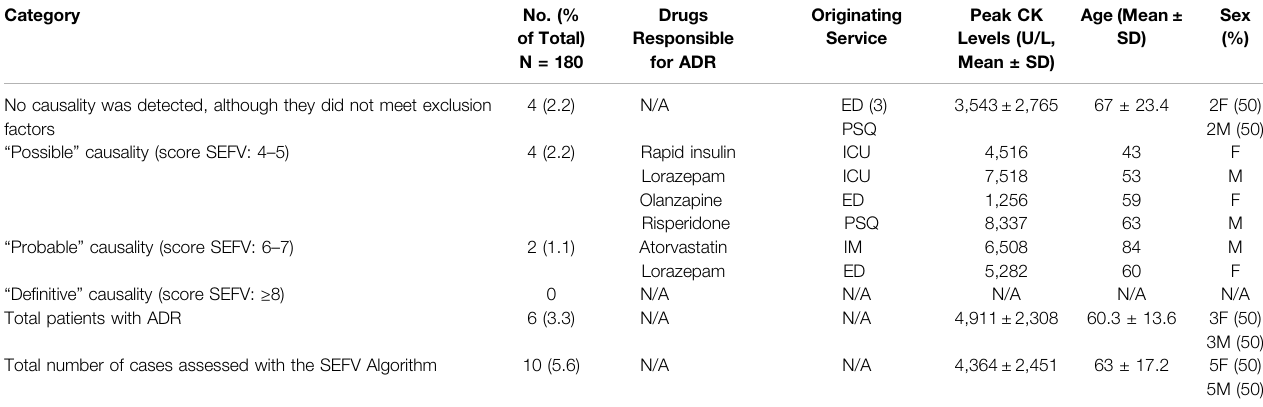
TABLE 2 | Cases of rhabdomyolysis assessed using the SEFV Algorithm. Category No. (%